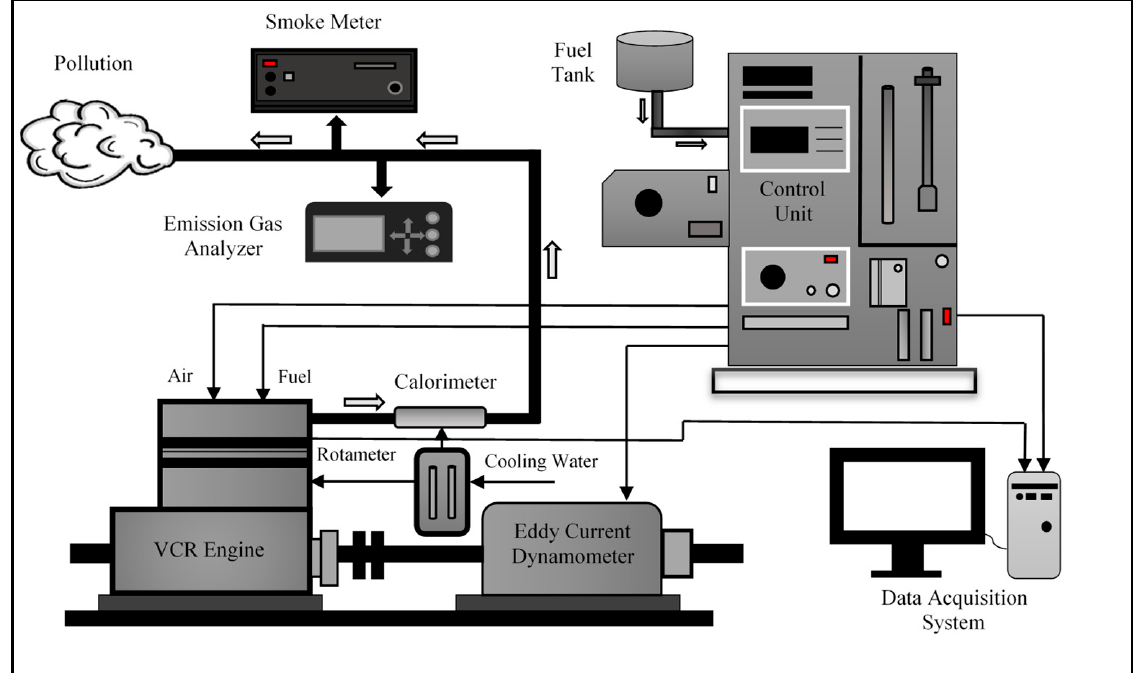
Figure 2. Schematic layout of the engine test rig. Table 4. Range, accuracy, and uncertainty of the instruments.